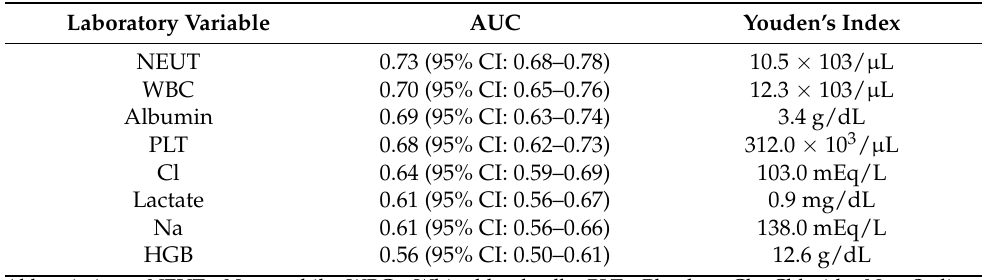
Table 2. Areas under the receiver operating characteristic curves (AUC) of laboratory values for predicting worse